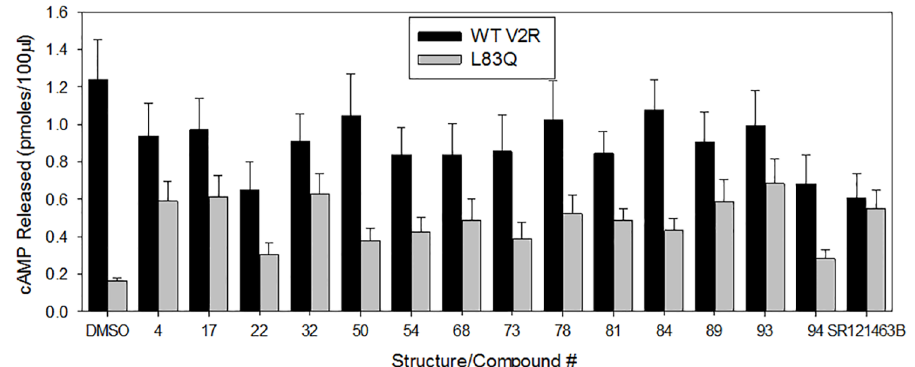
Fig 8. Rescue of cAMP production by WT and mutant-expressing HeLa cells by various pharmacoperones. Transiently transfected HeLa cells containinga total of 100 ng cDNA / 0.125 ml of hWT V2R or the L83Q mutant were treated with different pharmacoperones(10 μ M or #50 was 1 μ M) to show if the rescuedL83Q mutant is coupledto Gs (cAMP). The cells were incubatedwith the pharmacoperonesfor 16 h, then washed and stimulatedwith 1 μ M vasopressin containing 0.2 mM IBMX for 30 minutes and the cAMP responsewas measured. DMSO (vehicle) is a negativecontrol that does not rescue the mutant and SR121463B is a known pharmacoperonefor the L83Q mutant. The results shown in the figure are from at least 3 independentexperiments performed in quadruplicate(n = 3 ± SEM).